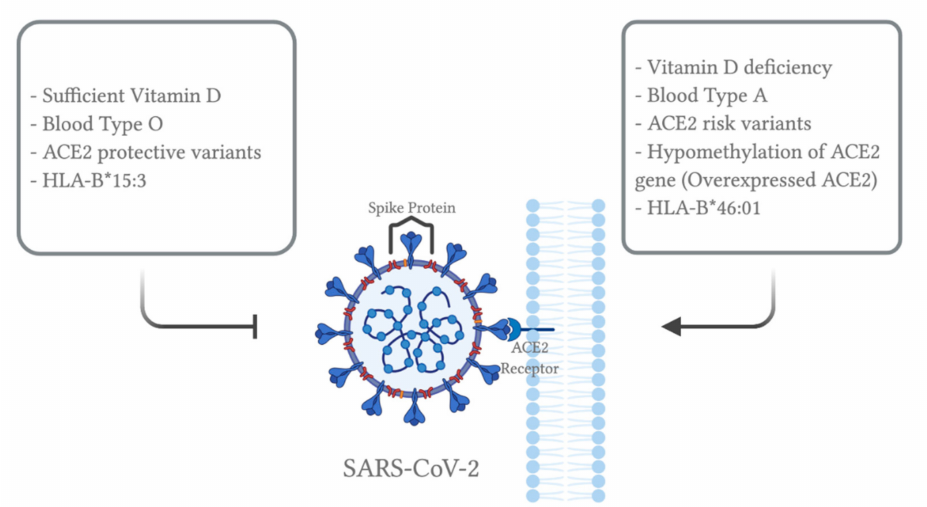
Figure 4. Factors affecting susceptibility to SARS-CoV-2 infection. All of the figures were created with